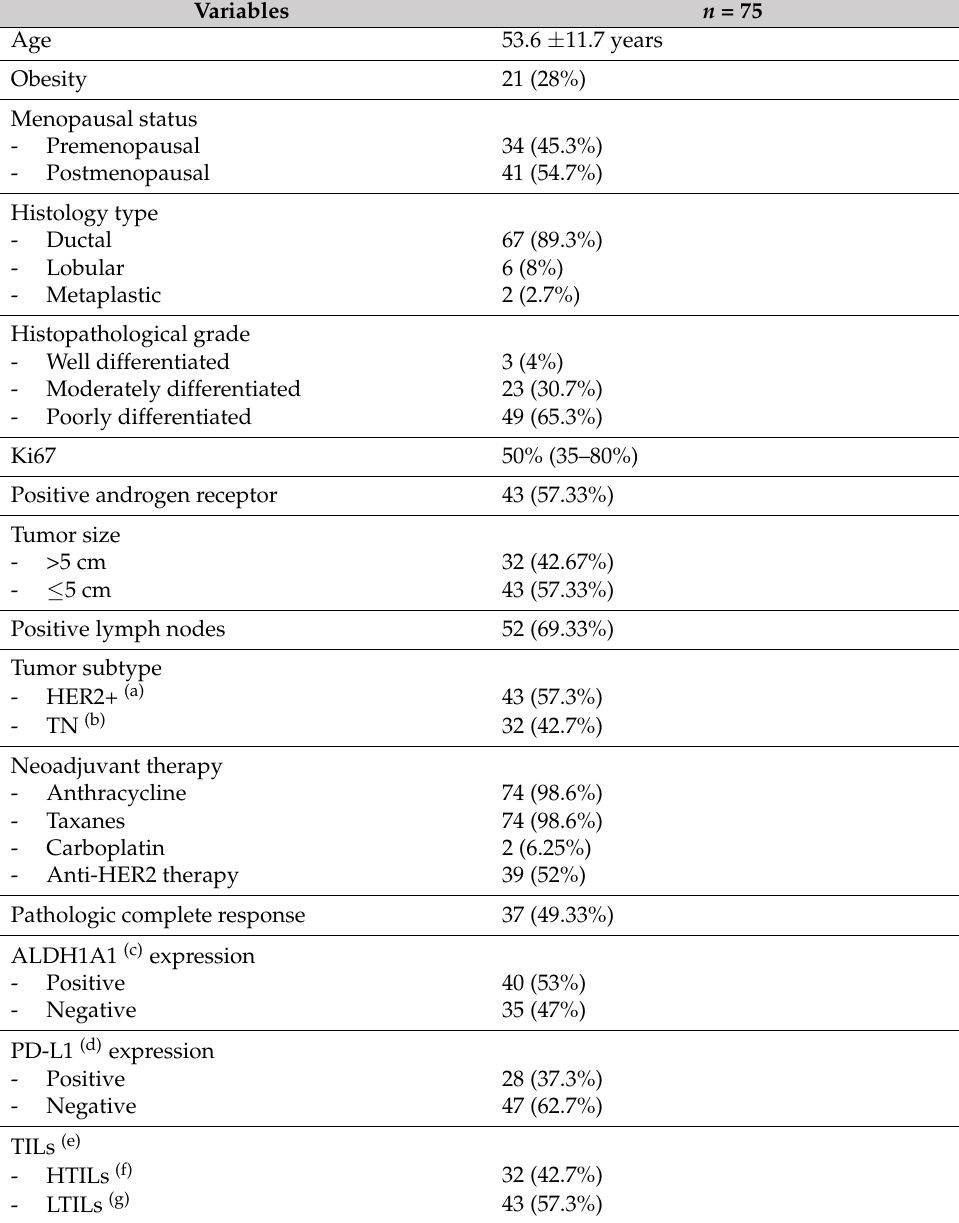
Table 1. Clinicopathologic characteristics of the entire